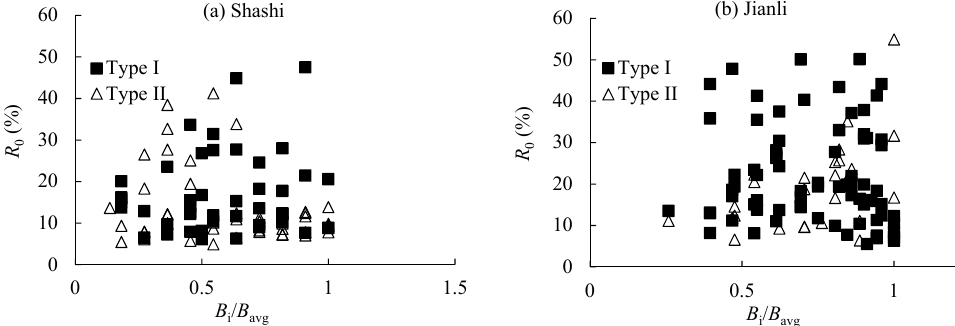
Figure 6. Vertical distribution of S i /S ia with different ω / u * , ( a ) for ( ω / u * )>0.05 and ( b ) for ( ω / u * ) < 0.0001. ω = settling velocity, u * = over shear velocity, S i = measured concentration of the vertical profile (kg/m 3 ), and S ia = measured concentration of the near-bed point (kg/m 3 ).